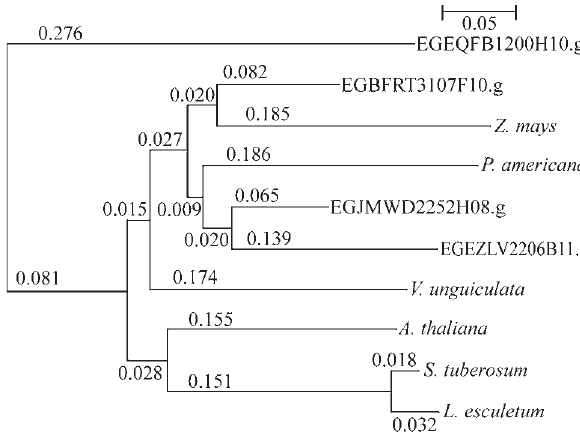
Figure 2 - Dendrogram showing the distance relations between the amino acid sequences of 9- cis -epoxycarotenoid dioxygenase for Eucalyptus clusters EGEZLV2206B11.g, EGJMWD2252H08.g, EGBFRT3107F10.g and EGEQFB1200H10.g, and the 9- cis -epoxycarotenoid dioxygenase of A. thaliana , L. esculetum , S. tuberosum , V. unguiculata , Z. mays and P. americana . The phylogenetic distance between sequences in the tree was calculated using the neighbor-joining algorithm.